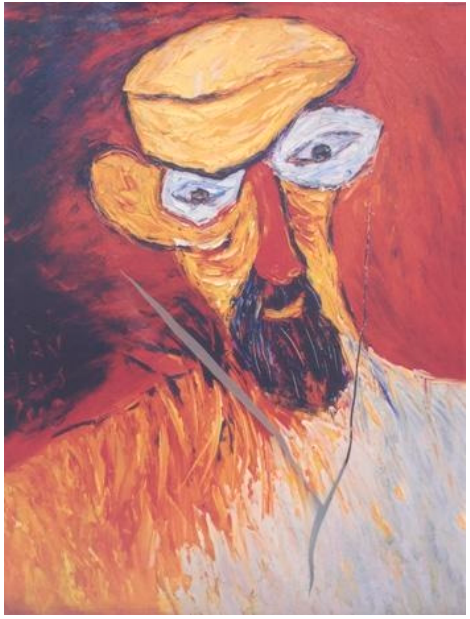
Figure A21. Ong gia cong nhan —Van Tho. The image was sourced from Nhan Dan Newspaper (An 2011).